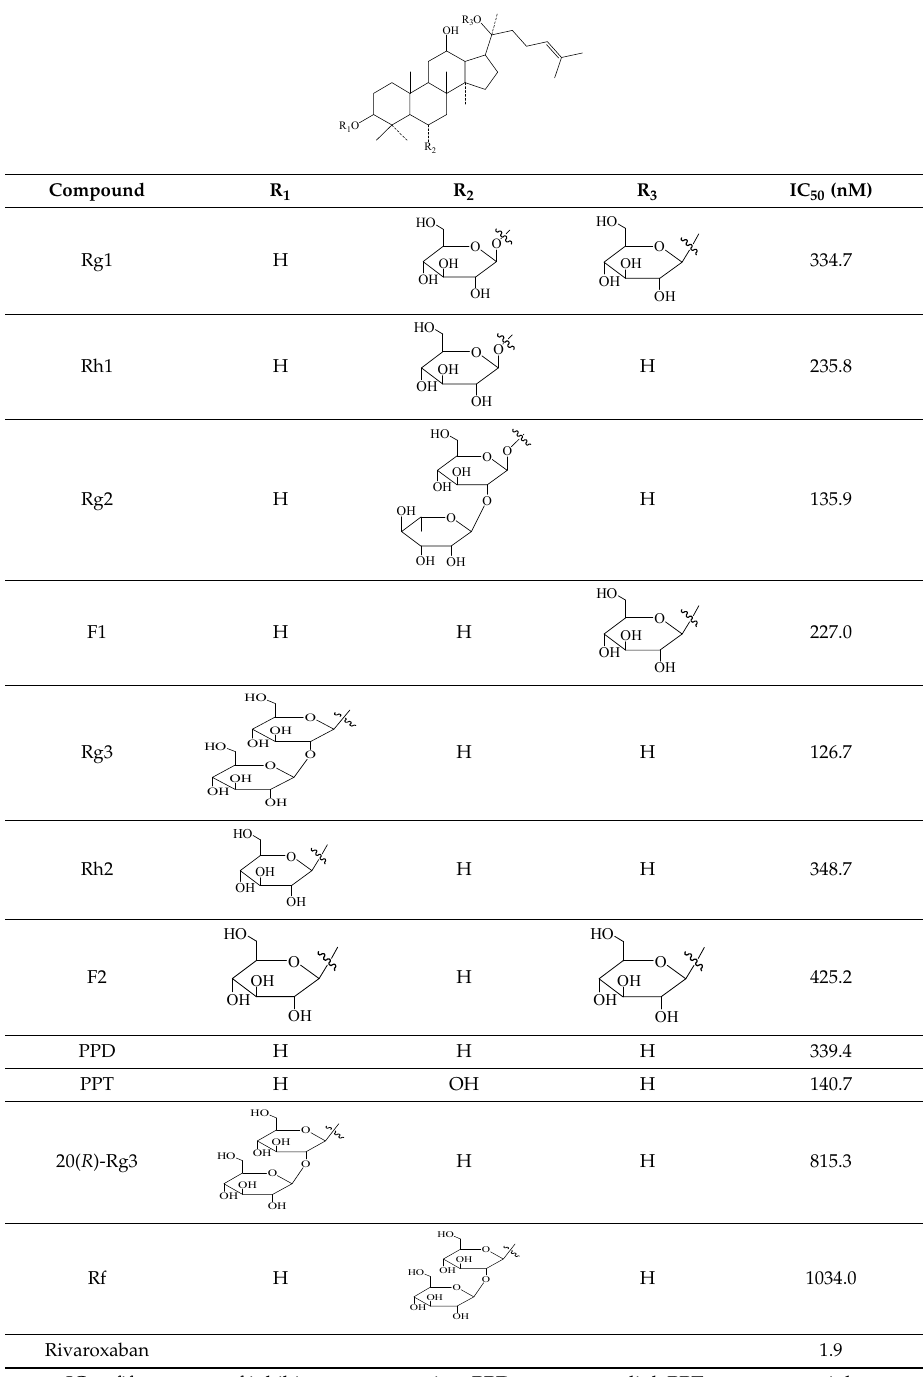
Table 1. The structures of 11 ginsenosides and their anticoagulation activities against coagulation factor Xa (FXa).